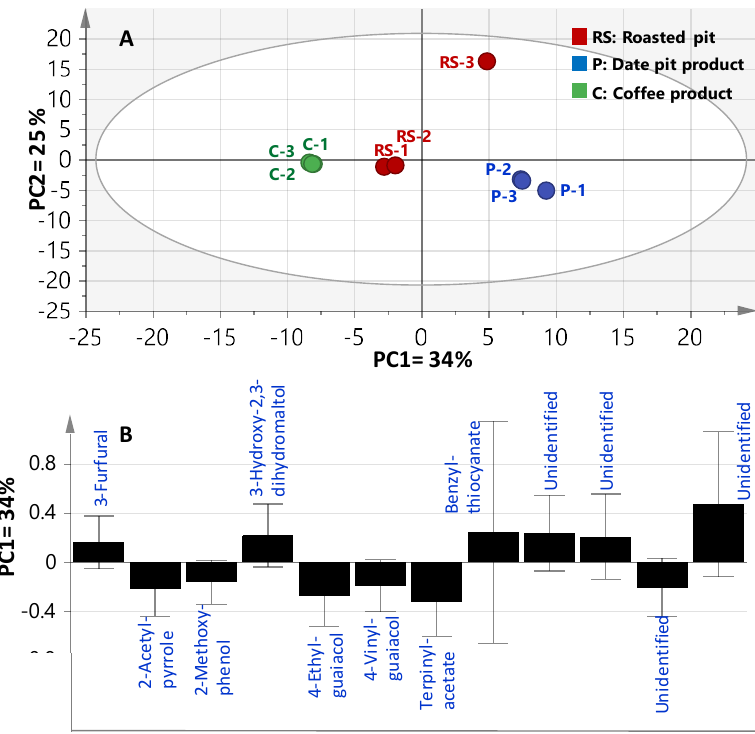
Figure 2. SPME-GCMS based principal component analysis of roasted pit (RS), pit products one and two (merged—P) and coffee product (C) ( n = 3). The metabolome clusters are located at the distinct positions described by the two vectors of principle component one (PC1) (34%) and PC2 (25%). A. Score Plot of PC1 vs. PC2. B. Loading plot for PC1 and PC2.